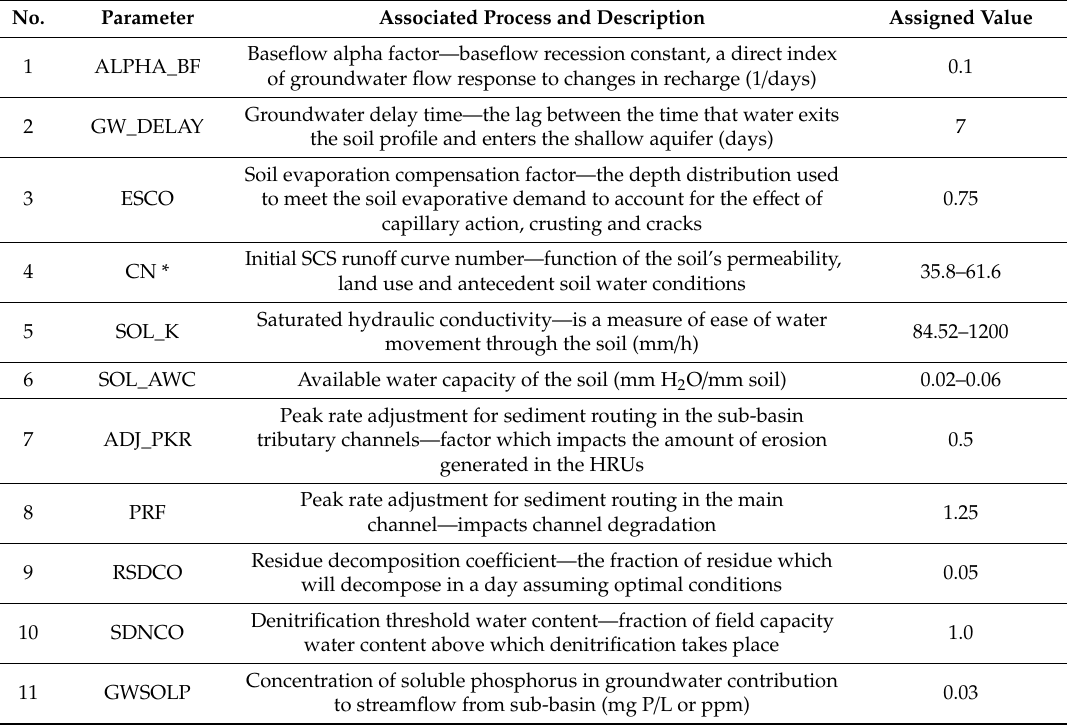
Table 3. Calibration of sensitive parameters and fitted values for the Minija River basin.